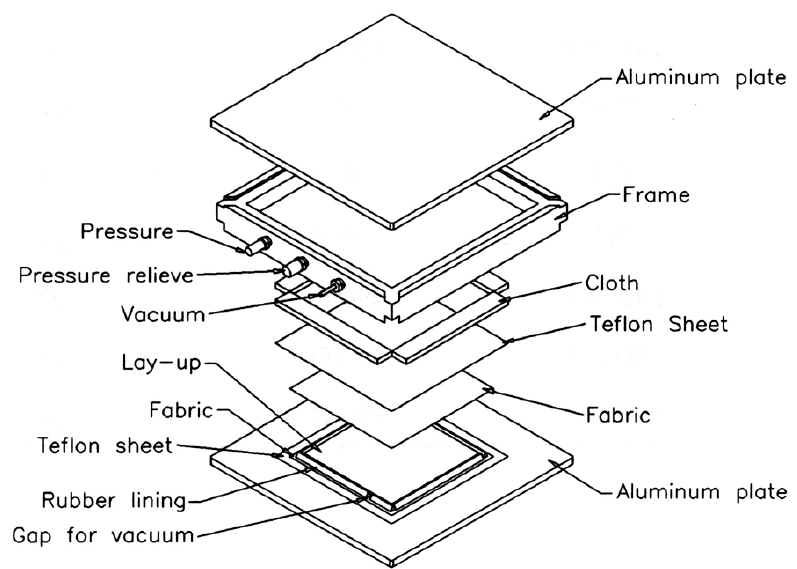
Figure 1. Schematic assembly of the two-chamber press-clave for PMC curing [14].